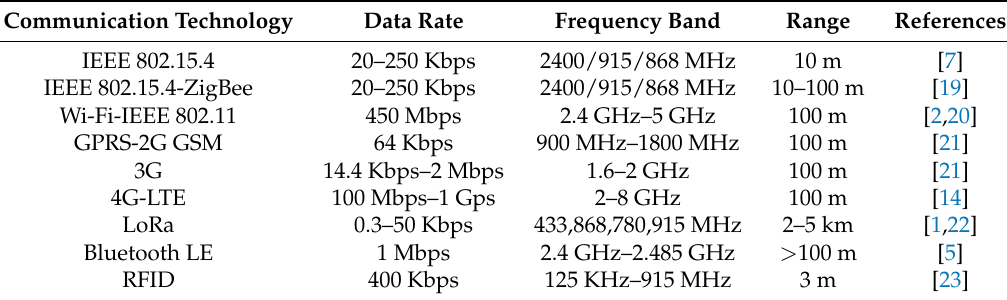
Table 3. Smart farming networking